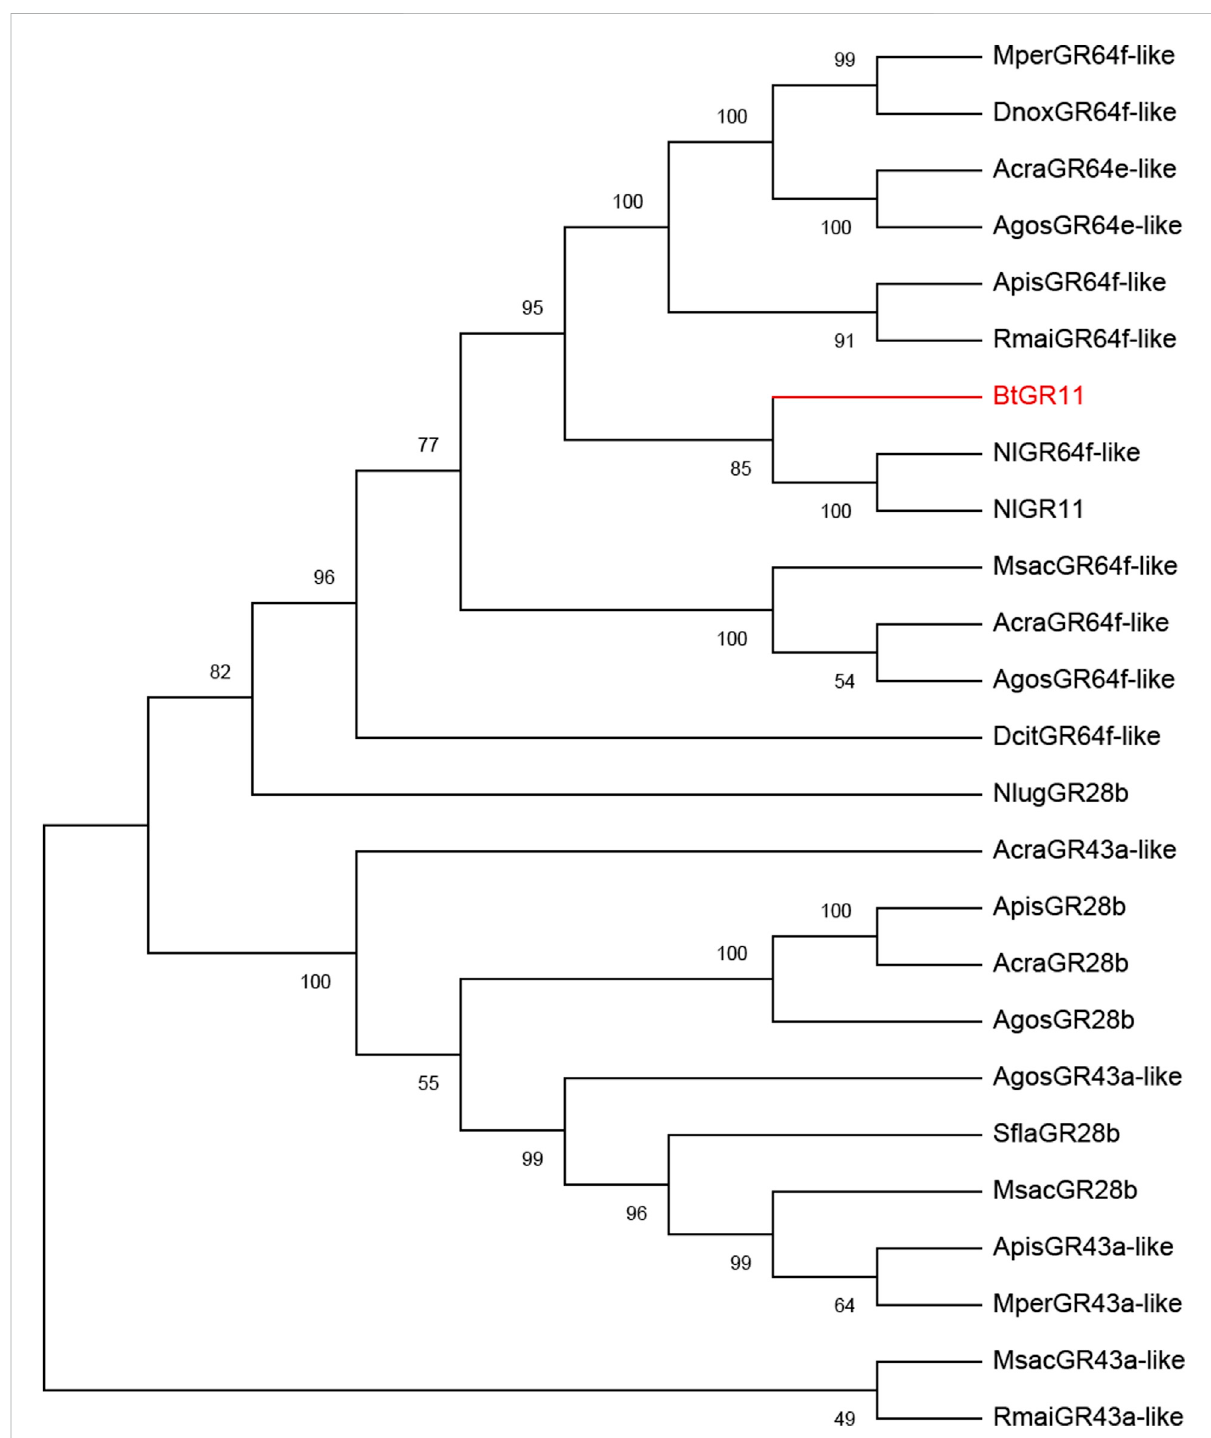
FIGURE 2 PhylogenetictreeofBtGR11andotherhemipterangustatoryreceptorsbasedonaminoacidsequences.GenenamesandGenBanknumbersareas follows: ApisGR28b, ApisGR43a-like, ApisGR64f-like: Acyrthosiphon pisum (XP_008178128.1, XP_003244120.4, XP_001942787.2); AcraGR43a-like, AcraGR64e-like,AcraGR64f-like,AcraGR28b: Aphiscraccivora